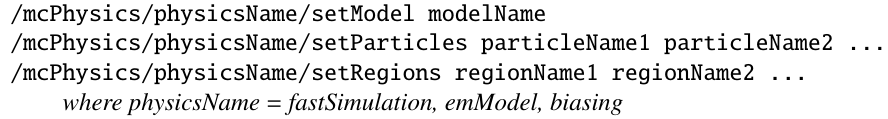
Table 1. User interface commands to define the special physics